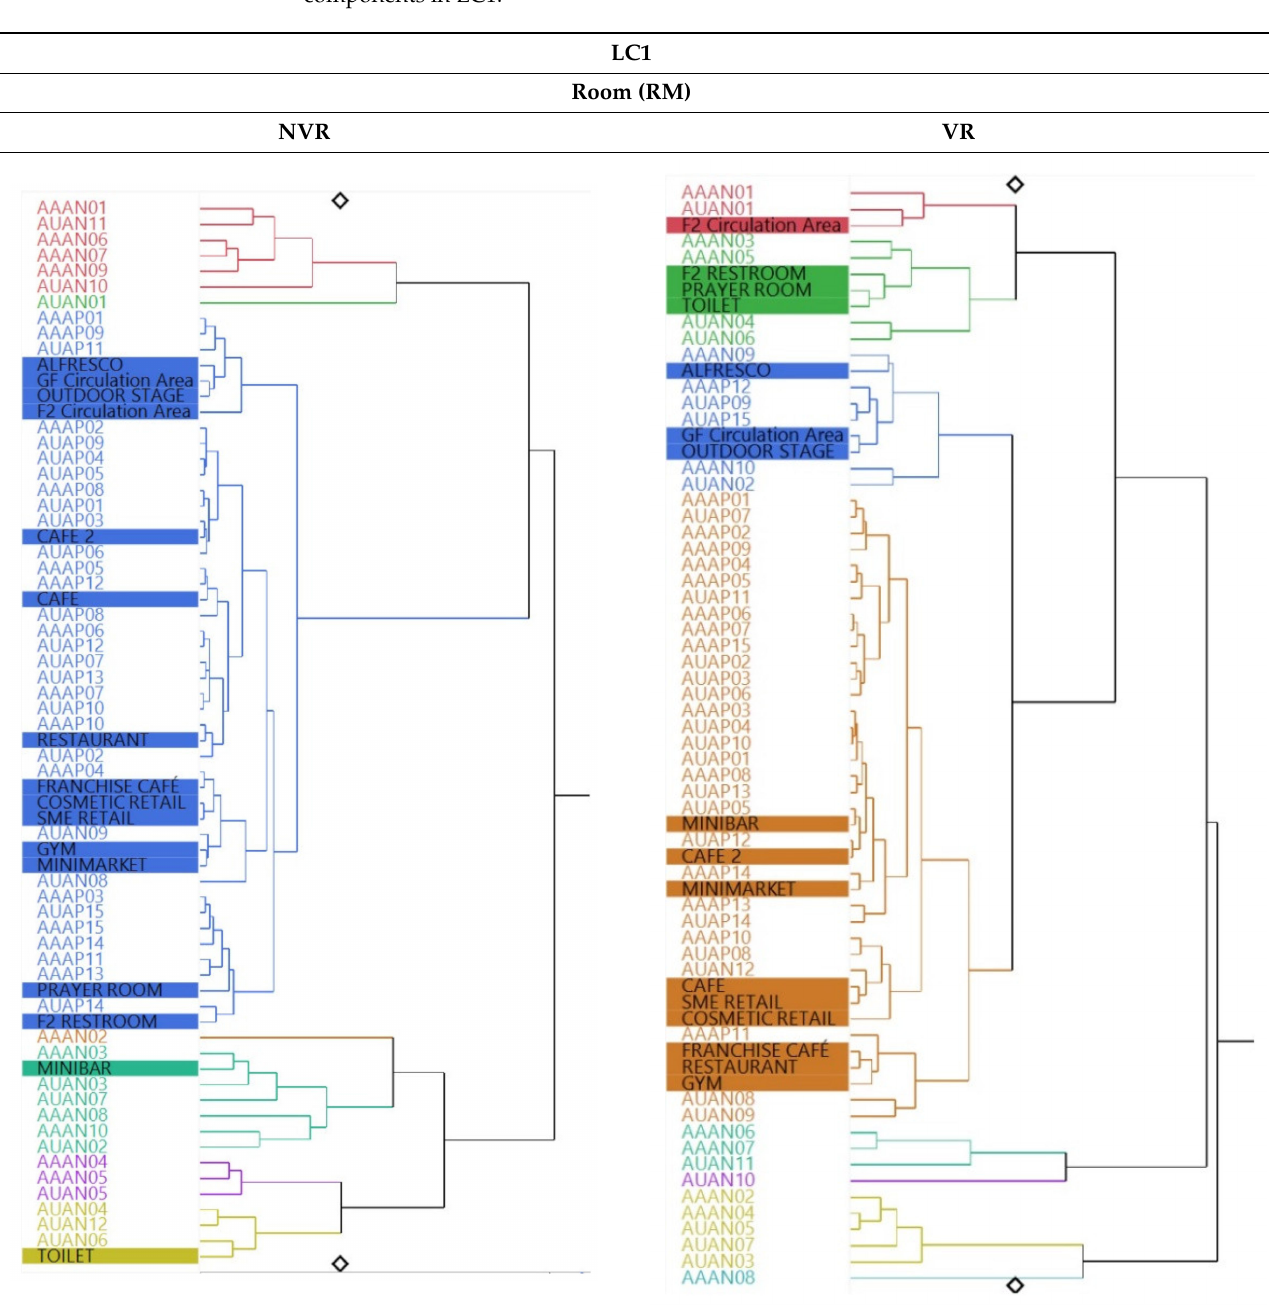
Table 9. Dendrograms from the hierarchical analysis method between affordances and design components in